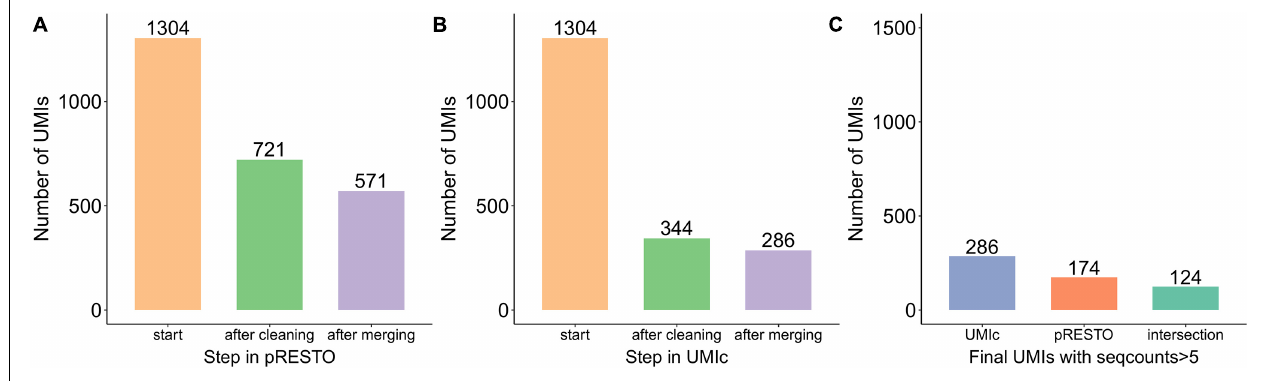
FIGURE 7 | Bar plots showing the number of UMIs processed at each step by (A) pRESTO and (B) UMIc as well as (C) the common UMIs of the two tools.